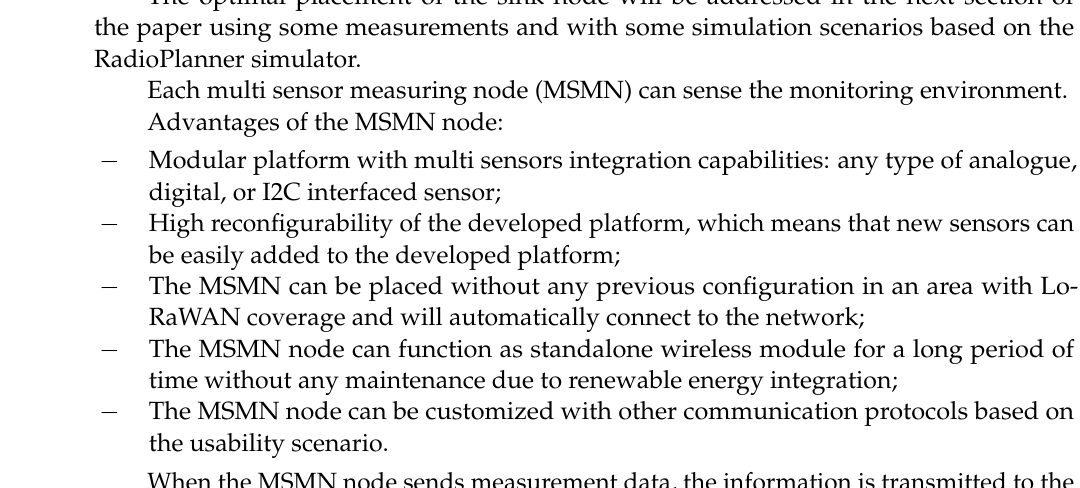
Figure 3. The proposed smart grid architecture based on the LoRaWAN communication.